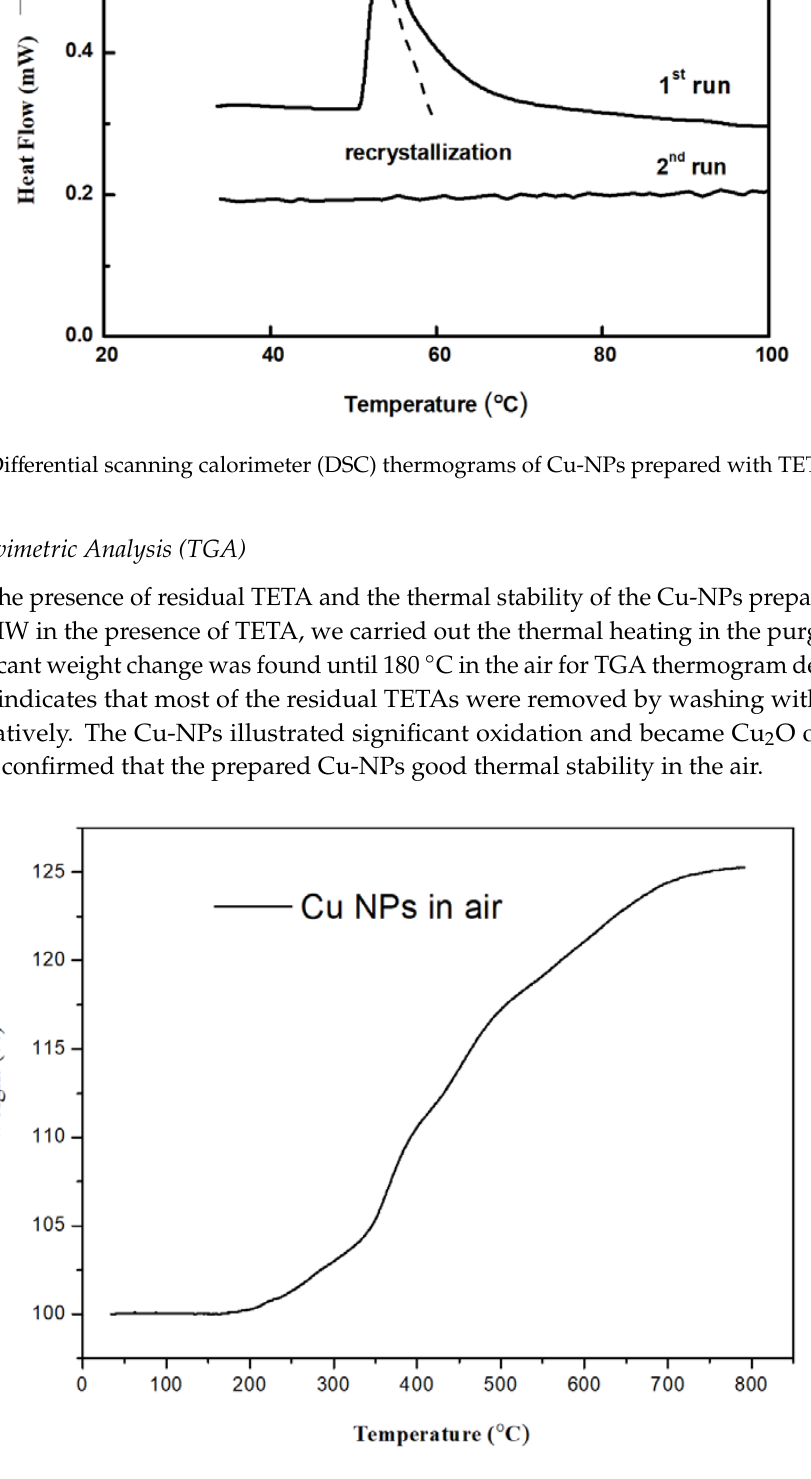
Figure 7. Thermogravimetric Analysis (TGA) thermogram of Cu-NPs in purging air (prepared with TETA / Cu + 2 ratio equals to 2.5 /